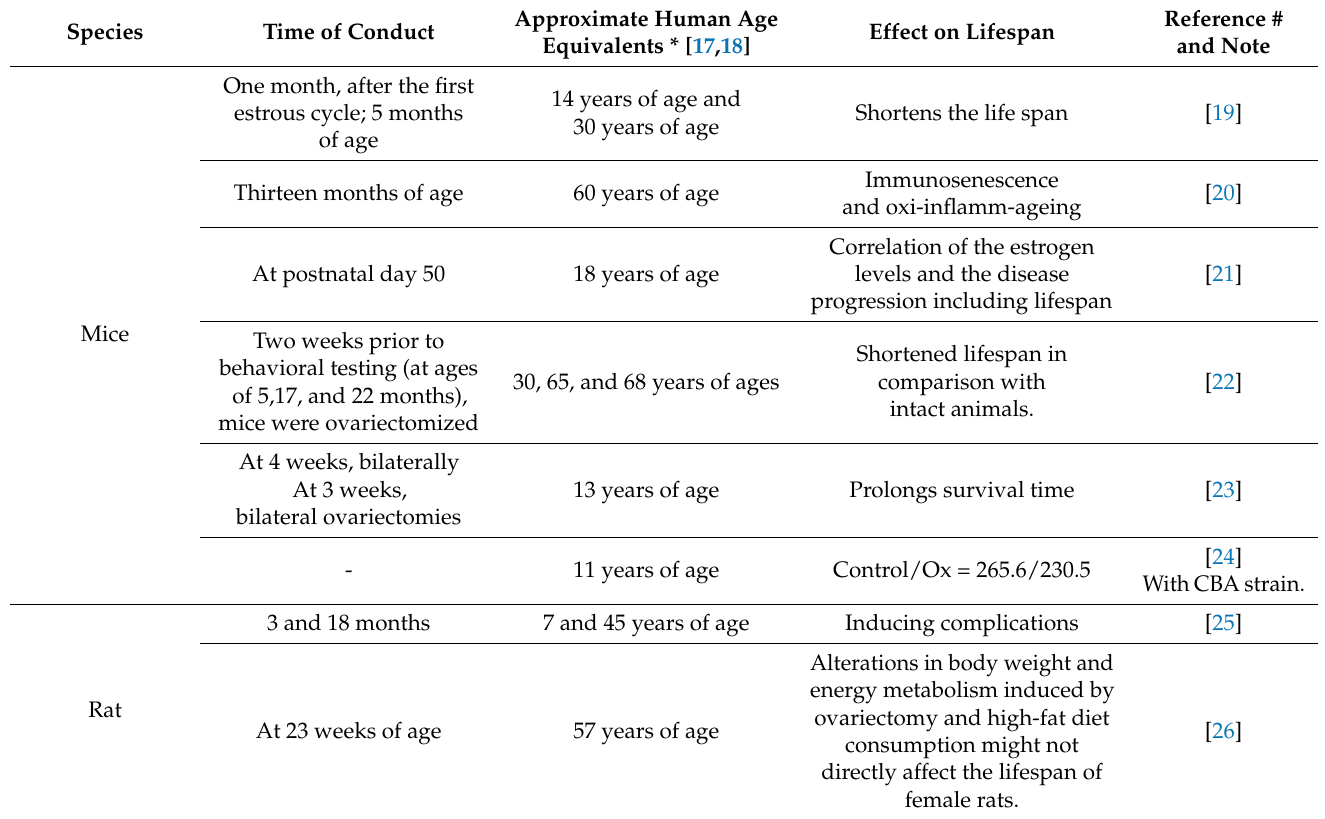
Table 1. Examples of the effects of ovariectomy at different stages and effects in mouse and rat